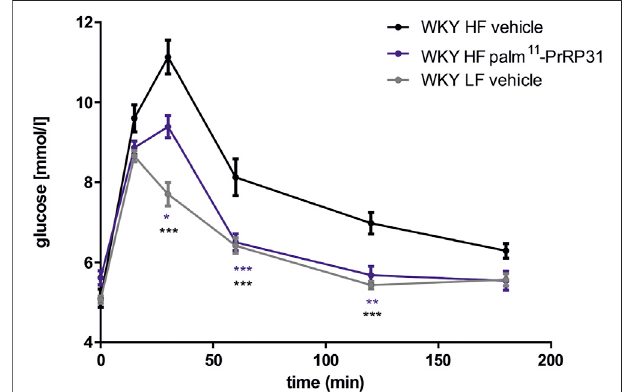
FIGURE 2 | Effect of chronic treatment with palm 11 -PrRP31 on glucose tolerance response in DIO Wistar Kyoto (WKY) rats. Rats were treated with palm 11 -PrRP31 for 3 weeks (WKY HF palm 11 -PrRP31 group). Oral glucose tolerancetest(OGTT) wasperformedafterovernightfastingattheendof experiment.Resultsareshownasaglucosepro fi lemodi fi edfrom( Č ermáková et al., 2019). Data are presented as means ± S.E.M. Statistical analysis was performed by Two-way ANOVA with Tukey post hoc test, signi fi cance is p < 0.05, ** < 0.01, *** < 0.001 vs WKY HF vehicle treated group. DIO Diet induced obesity, HF high fat, LF low